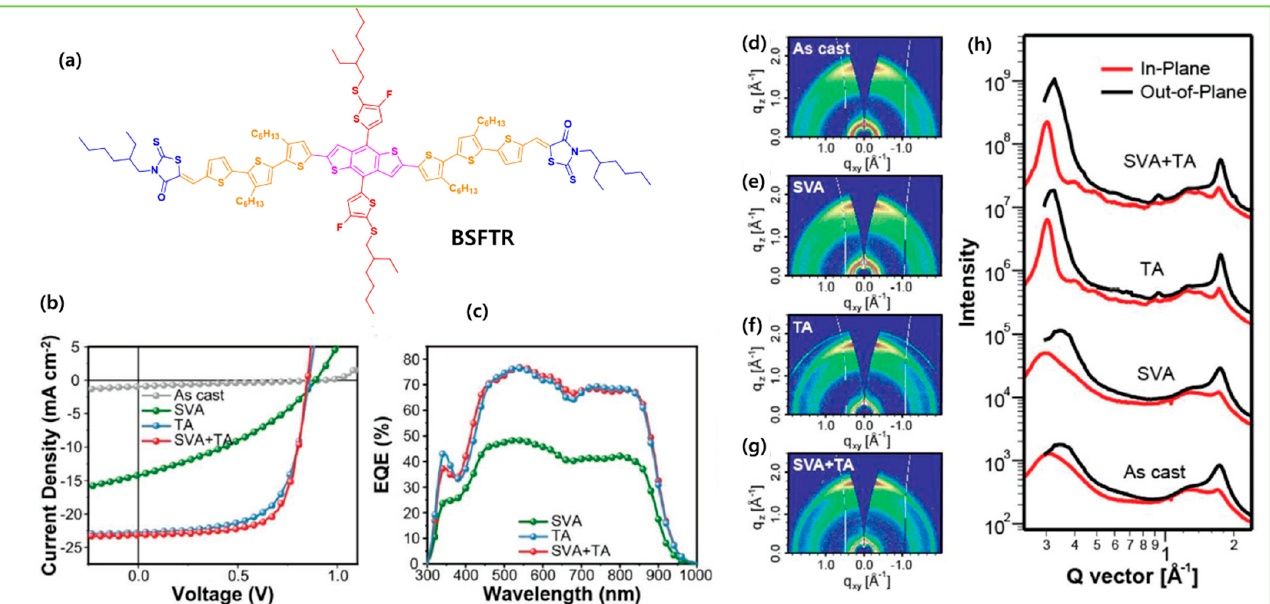
Figure 16. ( a ) Chemical structure of H11, H13, and H14 donors. ( b , c ) Two-dimensional GIWAXS patterns without and with thermal annealing. ( d , e ) In-plane and out-of-plane 1D line cuts of the neat donor films without and with thermal annealing. ( f – k ) Two-dimensional GIWAXS patterns. ( l , h ) In-plane and out-of-plane scattering profiles of the blend films without and with thermal an- nealing. Adapted with permission from [83]. Copyright 2020, John Wiley and Sons.